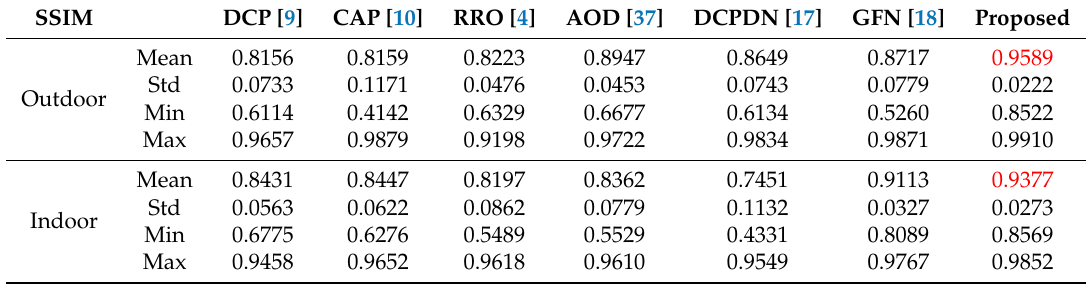
Table 4. Comparative SSIM results of dehazing methods on SOTS. Best score is marked in red.